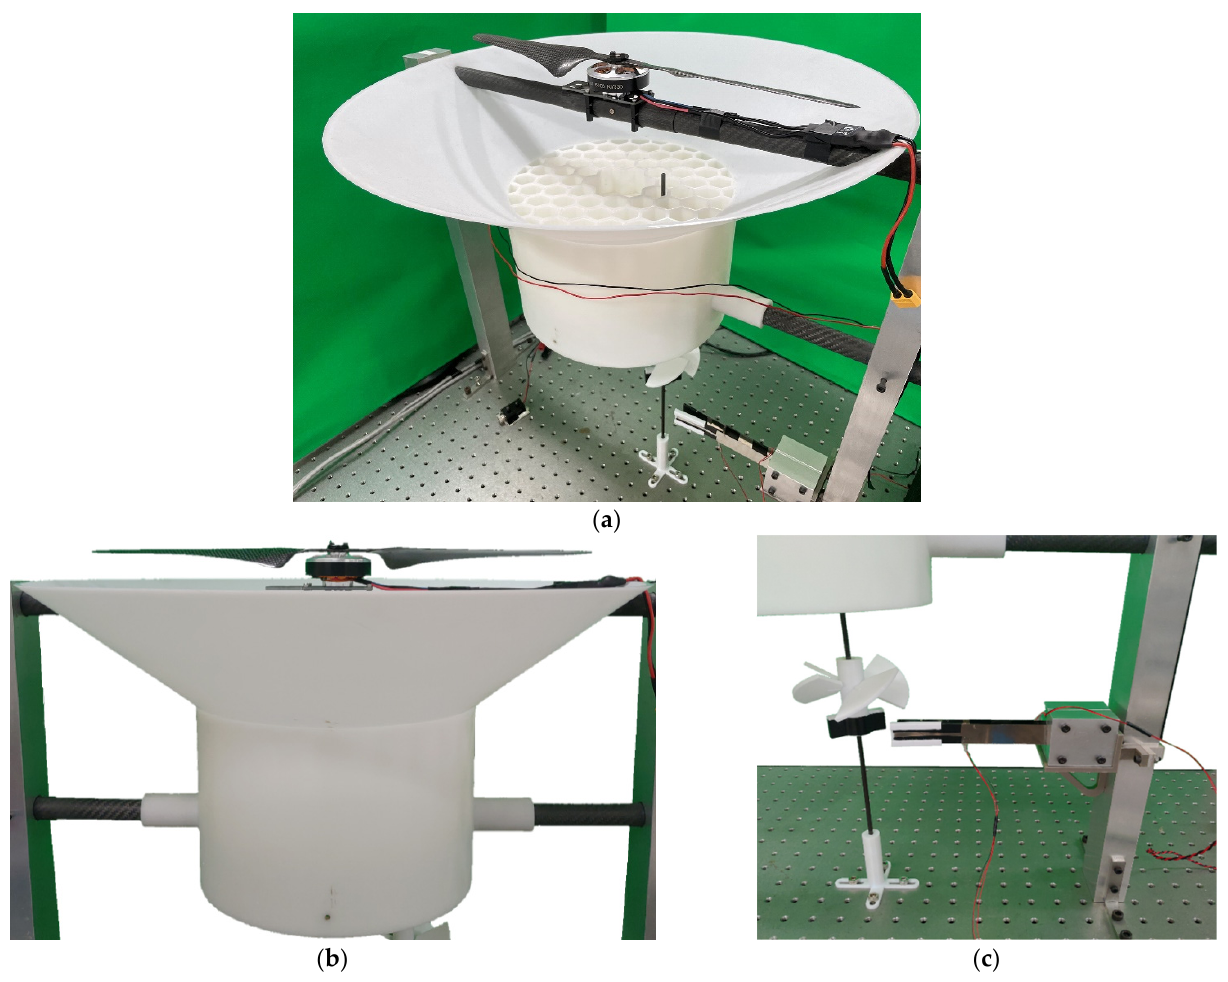
Figure 14. The assembly of the wind driven magneto-electric vibration energy harvester system. ( a ) brushless motor with a two-bladed rotor, ( b ) wind collecting cover, ( c ) windmill, and the magneto-electric VEH system.